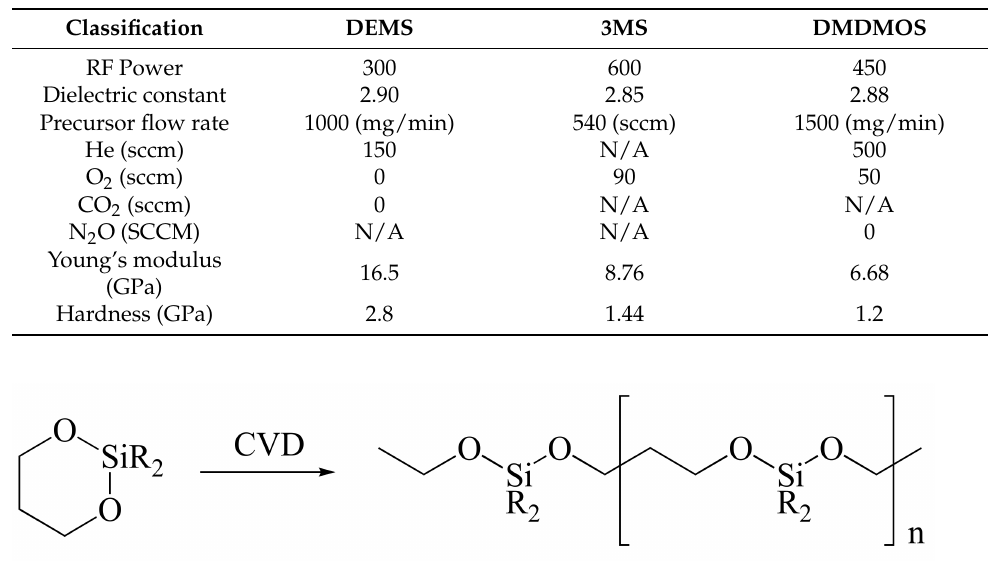
Table 3. The preparation conditions and dielectric properties of ILDs made with DEMS, 3MS, and DMDMOS precursors [22].